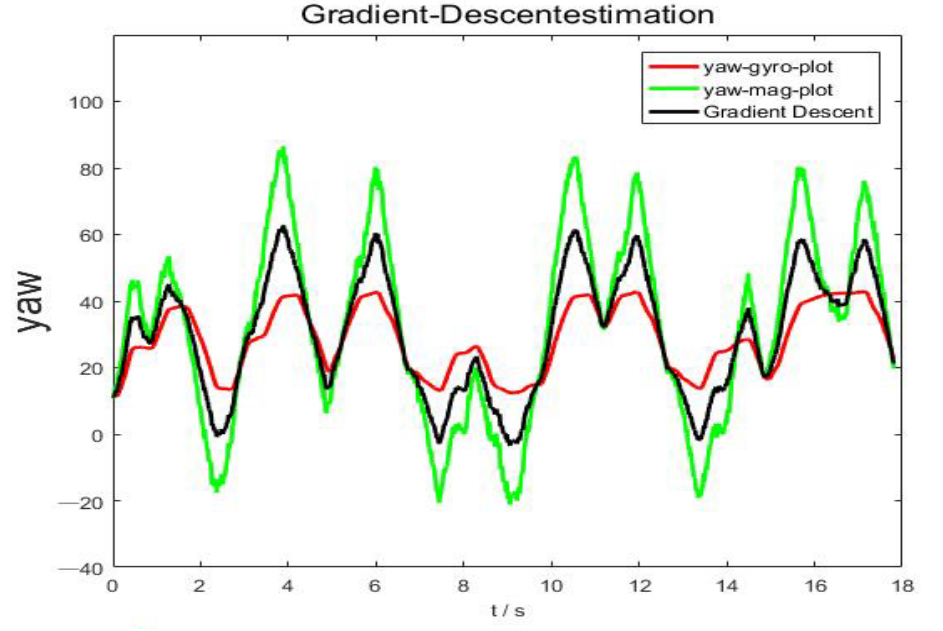
Figure 15. MPU9250. The result of GD data fusion.